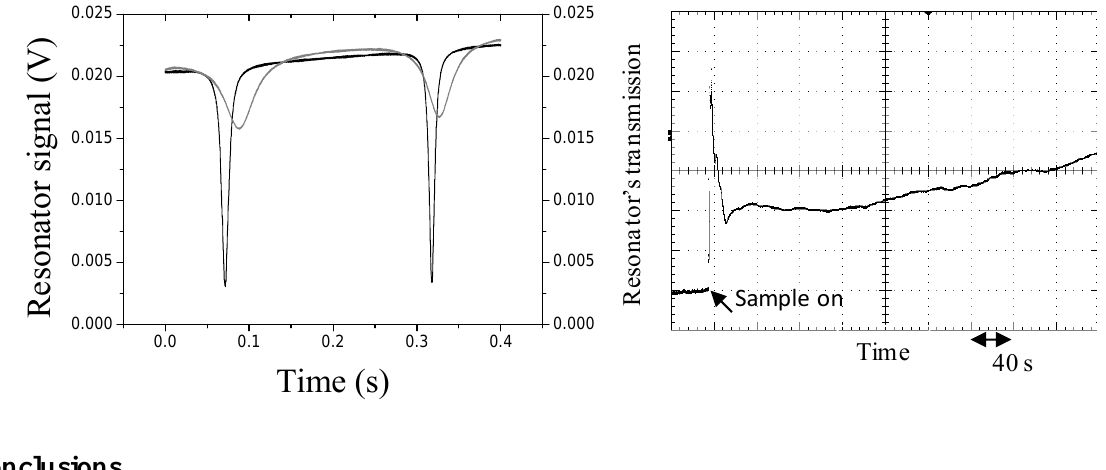
Figure 21. Cavity transmission signals in different cases. Left: free-running laser case with no sample on the EAB (black line) and with a sample (glycerol diluted at 99.5% with D causing a small index overlay (gray line); right: laser-locked condition with the sample on the